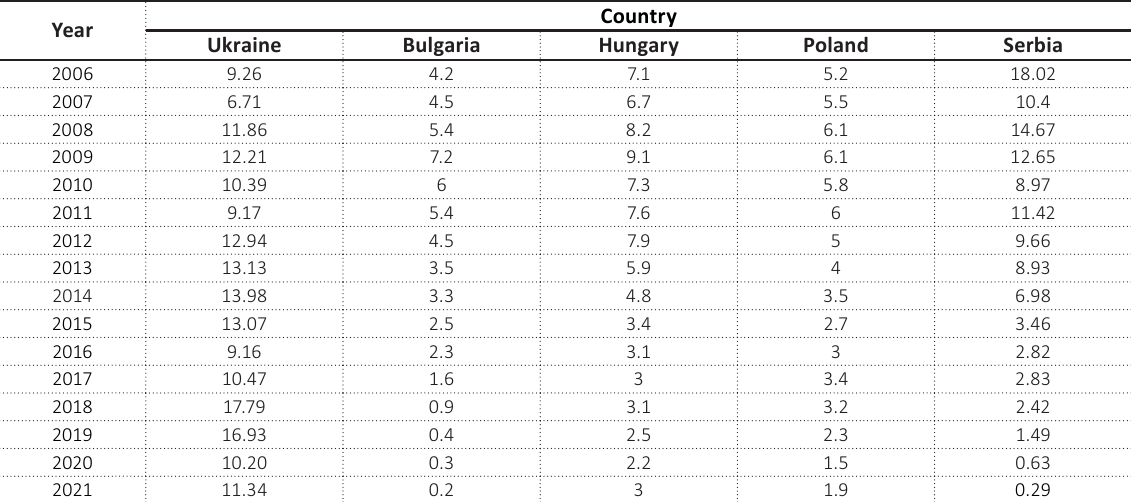
Table A5. Government securities yield, Ukraine, Bulgaria, Hungary, Poland, and Serbia, 2006–2021, in %